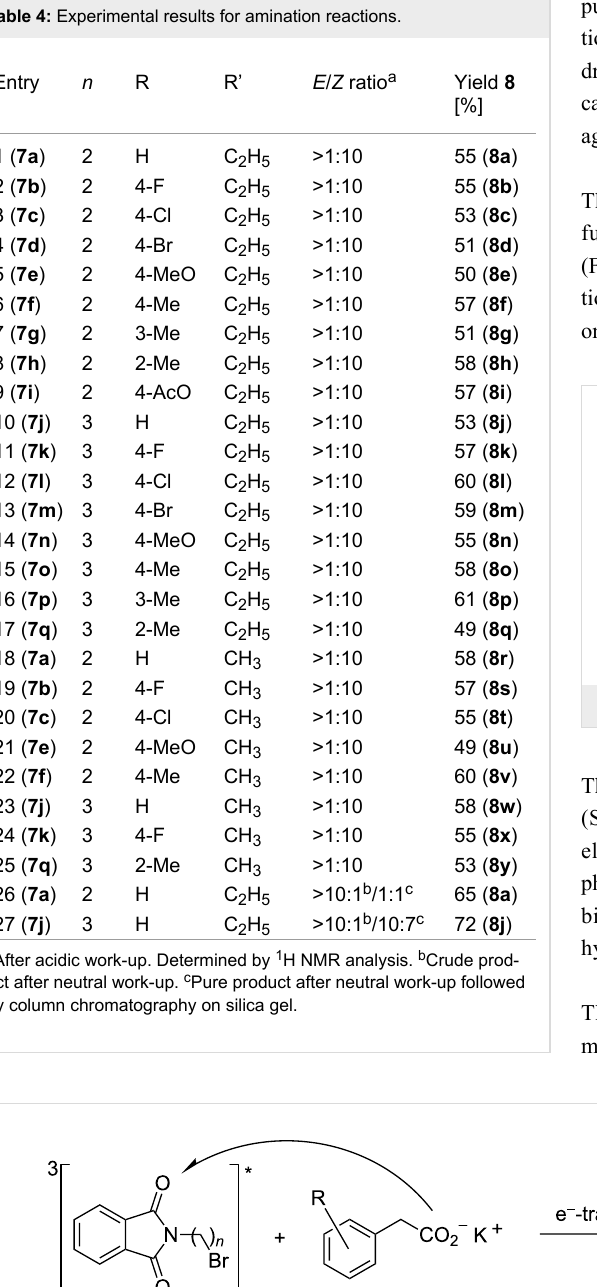
Table 4: Experimental results for amination reactions.